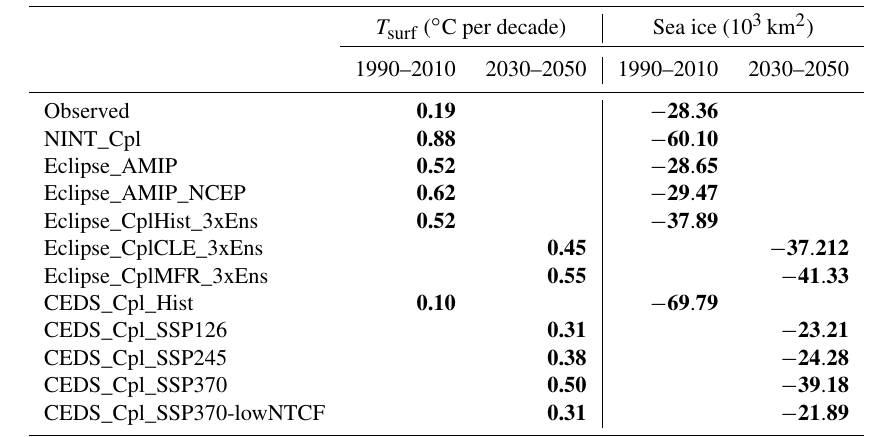
Table 7. Trends in near-surface temperature ( T surf ) and annual mean sea-ice extent in 1990–2010 and 2030–2050 periods as calculated by the GISS-E2.1. The bold numbers indicate the changes in the 2030–2050 mean compared to the 1990–2010 mean that are statistically significant on a 95% significance level.